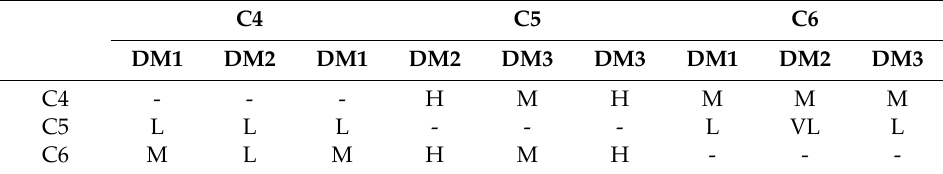
Table A3. Linguistic evaluations of the criteria for dimension 2.